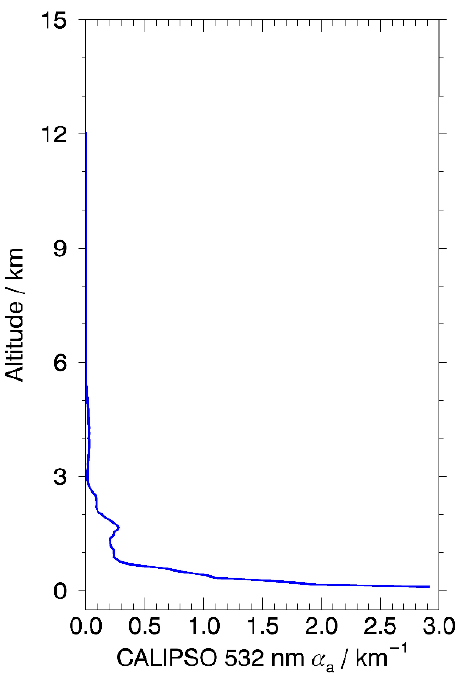
Figure 1. Monthly average profile of 532 nm α a in January 2013 for the spatial grid (central point: 30.0° N, 112.5° E) from the Cloud-Aerosol Lidar and Infrared Pathfinder Satellite Observation (CALIPSO) Lidar Level 3 Tropospheric Aerosol Data Product version 4.20. An aerosol-free region (at the altitudes of 9–12.1 km) is identified.